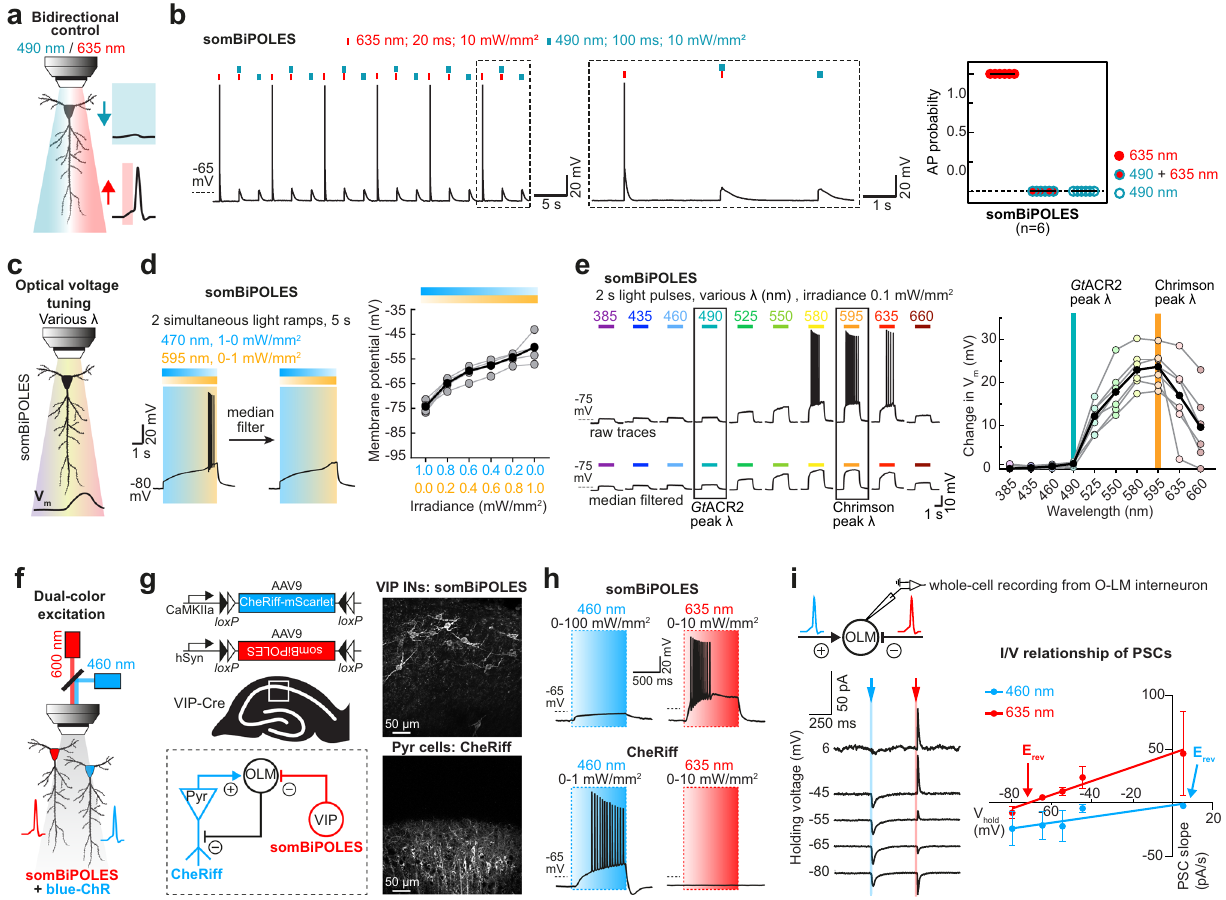
Fig. 4 Applications of BiPOLES: bidirectional control of neuronal activity, optical voltage tuning, and independent dual-color excitation of two distinct neuronal populations. a Schematic drawing illustrating bidirectional control of neurons with blue and red light. b Current-clamp characterization of bidirectional optical spiking-control with somBiPOLES. Left: Voltage traces showing red-light-evoked APs, which were blocked by a concomitant blue light pulse. Right: quanti fi cation of AP probability under indicated conditions (black horizontal lines: medians, n = 6 cells). c Schematic drawing illustrating control of membrane voltage with somBiPOLES. d Left: Representative membrane voltage traces from a somBiPOLES-expressing CA1 pyramidal cell during simultaneous illumination with 470-nm and 595-nm light ramps of the opposite gradient. Voltage traces were median- fi ltered to reveal the slow change in membrane voltage during the ramp protocol. Right: Quanti fi cation of membrane voltage at different 595/470 nm light ratios (black circles: medians, n = 5 cells). e Left: Representative membrane voltage traces of somBiPOLES in CA1 pyramidal neurons upon illumination with different wavelengths and equal photon fl ux. As in d voltage traces were median- fi ltered to eliminate action potentials and reveal the slow changes in membrane voltage during the light protocol. Right: Quanti fi cation of membrane potential along the spectrum showing optical voltage tuning at the indicated wavelengths. (black circles: medians, an irradiance of 0.1 mW mm − 2 was kept constant for all wavelengths, n = 6 cells). f Schematic drawing illustrating control of 2 neurons expressing either somBiPOLES (red) or a blue-light-sensitive ChR (blue). g Left: Cre-On/Cre-Off strategy to achieve mutually exclusive expression of CheRiff-mScarlet in CA1 pyramidal neurons and somBiPOLES in VIP-positive GABAergic neurons. Both cell types innervate OLM interneurons in CA1. Right: Example maximum-intensity projection images of two-photon stacks showing expression of somBiPOLES in VIP-interneurons (top) and CheRiff- mScarlet in the pyramidal layer of CA1 (bottom). h IC-recordings demonstrating mutually exclusive spiking of somBiPOLES-expressing and CheRiff- expressing neurons under red or blue illumination. i Postsynaptic whole-cell voltage-clamp recordings from an OLM cell at indicated membrane voltages showing EPSCs and IPSCs upon blue-light and red-light pulses, respectively. Right: quanti fi cation of blue-light and red-light-evoked PSCs and their reversal potential. Symbols show mean ± SEM, n 460 nm = 8 cells, n 635 nm = 7 cells, lines: linear regression fi t, R 2 = 0.06 and 0.20 for a blue and red light, respectively.